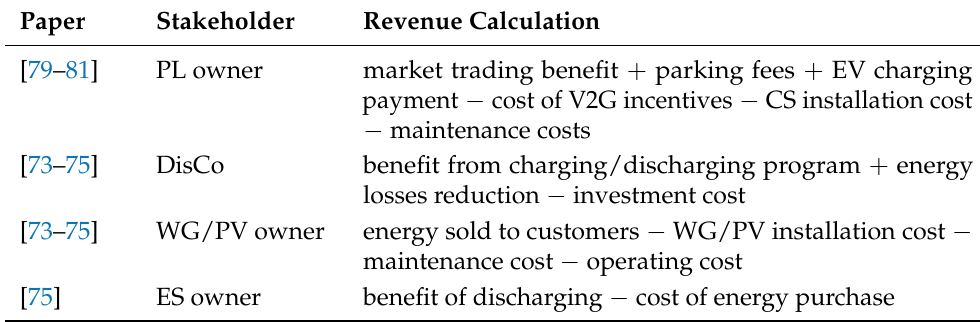
Table 2. Revenue calculation per